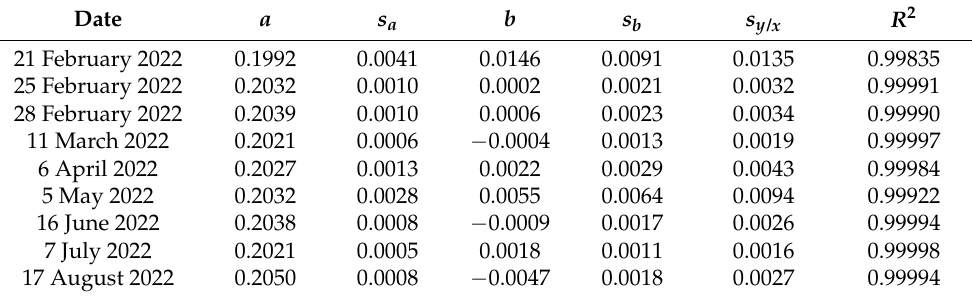
Table 2. Within-laboratory reproducibility of the six-point ( n = 6) calibration function ( y = a · x + b ) during a six-month period.